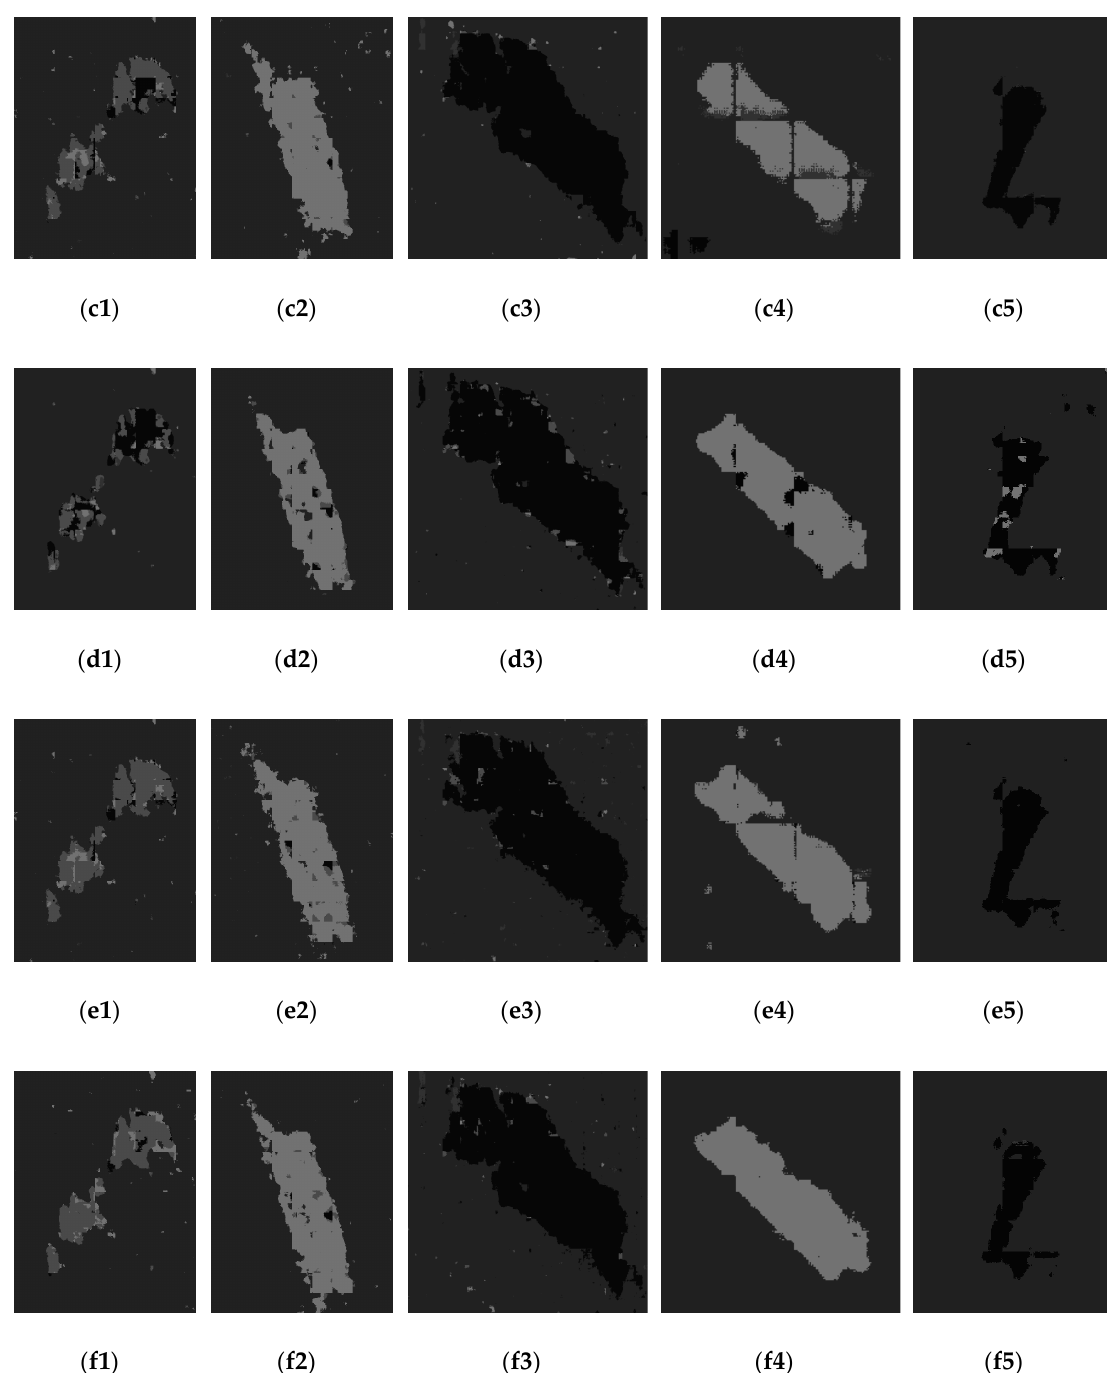
Figure 9. The results of dark spots area verified by polarized parameters, 1-3 in each group represents emulsion, 2 for biogenic look-alike, 3 for oil-spill area of Image 1, 4 and 5 represent biogenic look alike oil spill area of Image 2 and Image 3. ( a1 – a5 ) Ground truth, ( b1 – b5 ) H / A / Alpha, ( c1 – c5 ) H / A / SERD / Alpha, and oil spill area of Image 2 and Image 3. ( a1–a5 ) Ground truth, ( b1–b5 )H/A/Alpha, ( c1- ( d1 – d5 ) Scattering Coefficients, ( e1 – e5 ) Freeman 3-Component Decomposition, ( f1 – f5 )